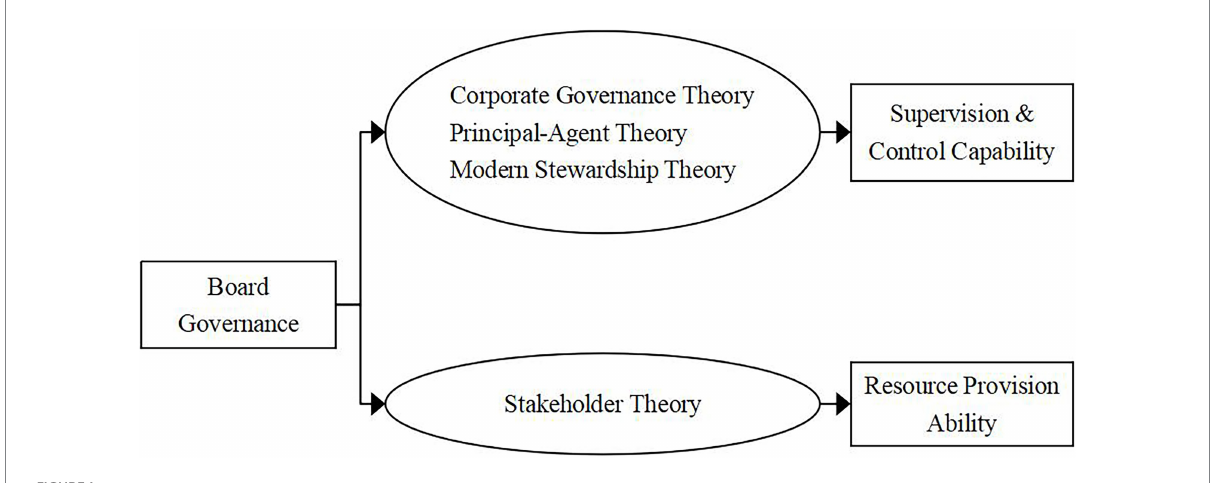
FIGURE 1 Theoretical framework of board